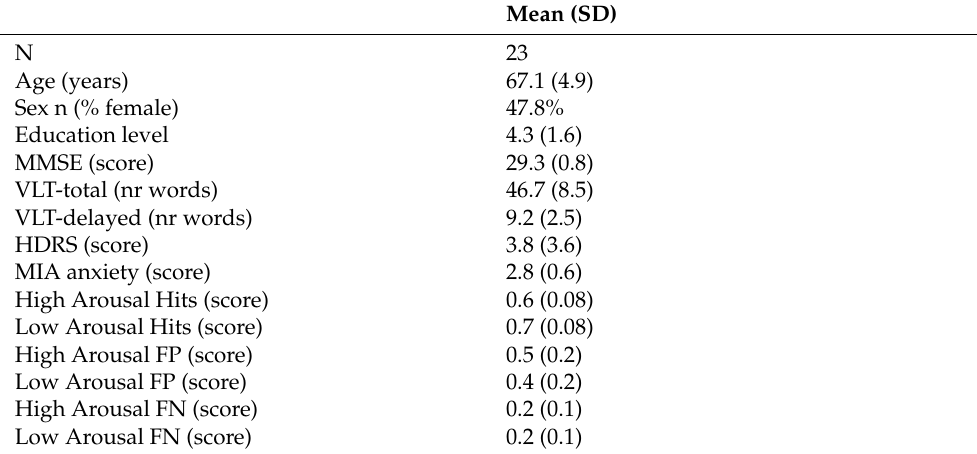
Table 1. Characteristics of Participants.